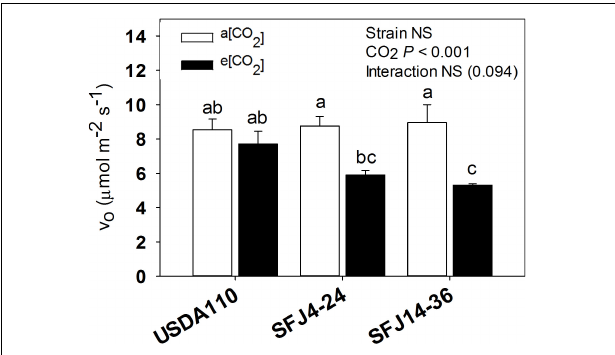
FIGURE 4 | Photorespiratory estimations from gas exchange measures. Estimated rate of RuBP Oxygenation ( v o ) in soybean leaves grown at a[CO 2 ] (400 ppm) and e[CO 2 ] (700 ppm) and inoculated with three Bradyrhizobium japonicum strains (USDA110, SFJ4-24, and SFJ14-36). Bars correspond to the mean ± SE of n = 6. Results of statistics are shown (two-way ANOVA, P < 0.05). Different letters indicate significant differences (Tukey post hoc test P <